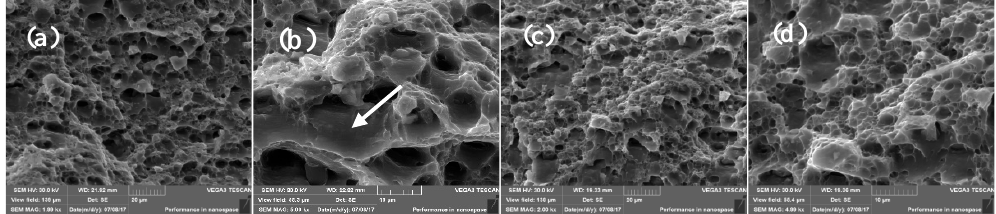
Figure 8. Fractures of the synchronous water cooling (SWC): ( a , b ) top, ( c , d ) bottom.